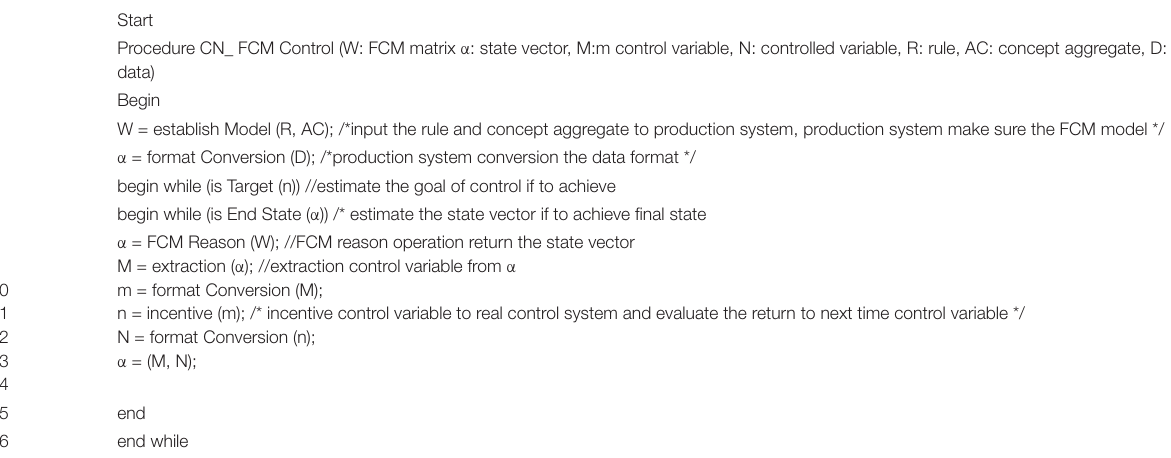
TABLE 1 | Algorithms for ballad creation under big data.